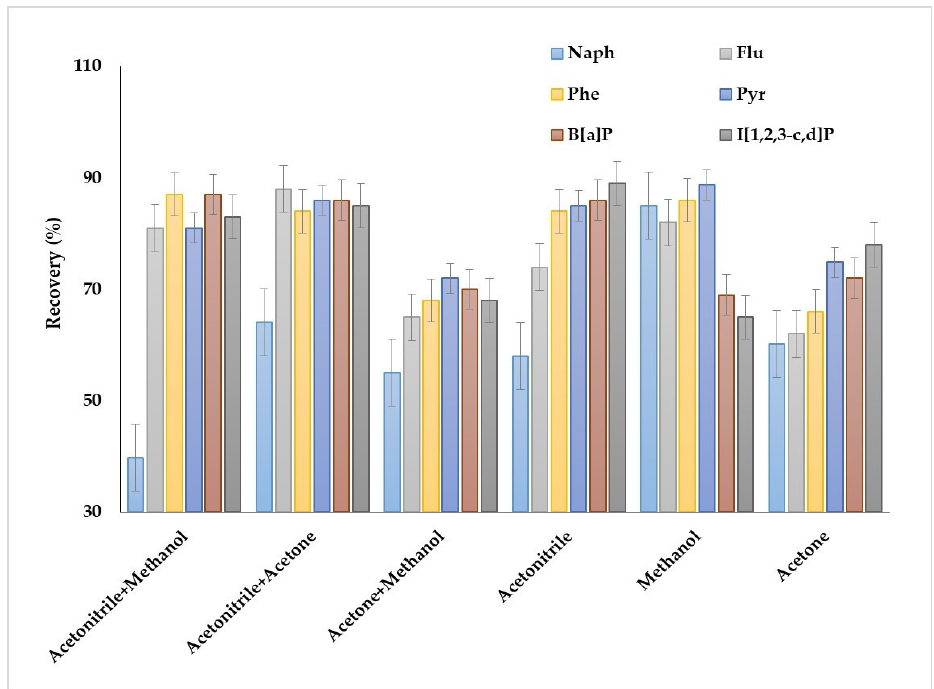
Figure 3. Effect of the dispersive agent compositions on the extraction recovery of PAHs.